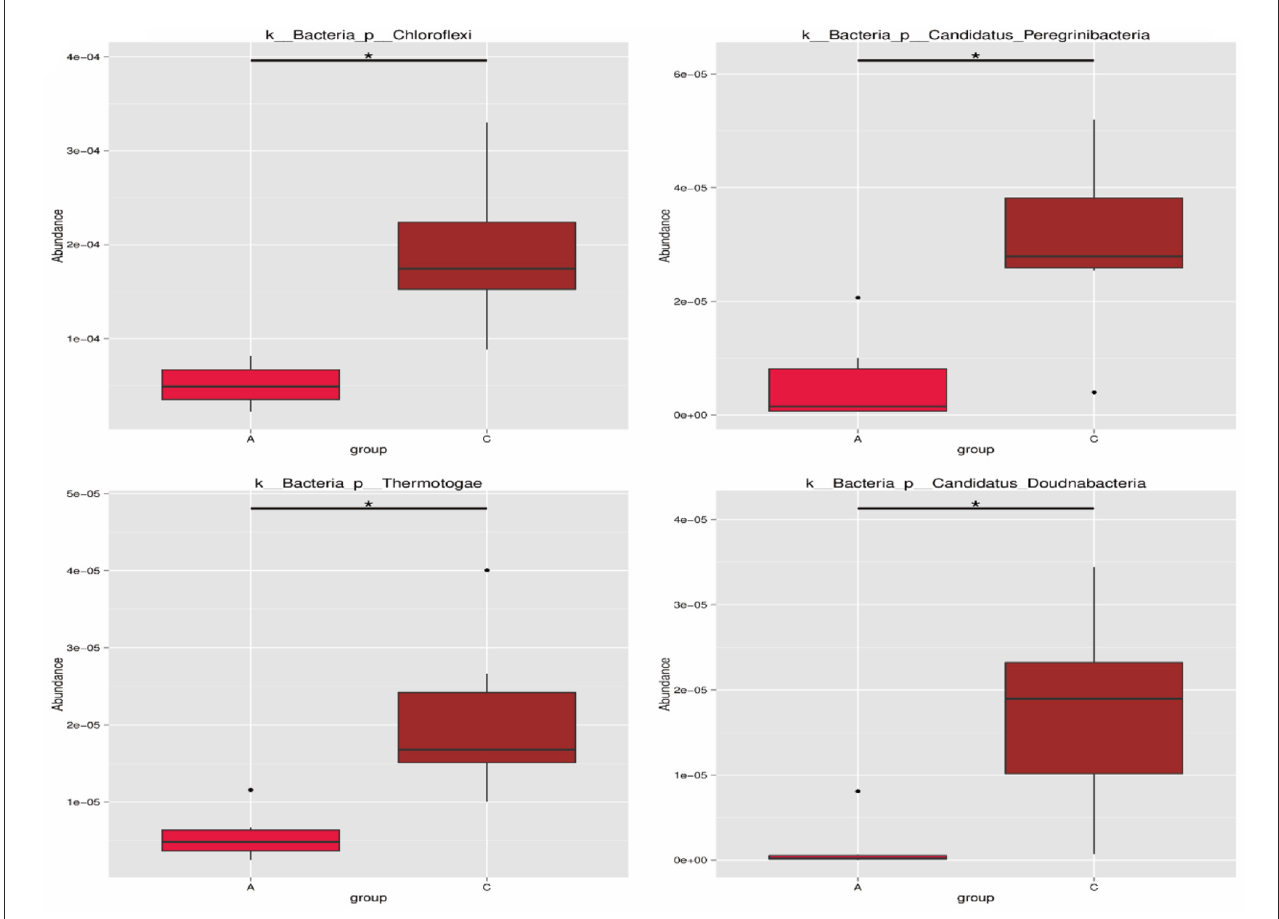
FIGURE4 Phylum level differential species. The horizontal axis is the sample grouping, and the vertical axis is the relative abundance of corresponding species; the horizontal lines represent two groups with significant differences. * Represents significant difference between the two groups ( q < 0.05), ** Represents extremely significant difference between the two groups ( q <